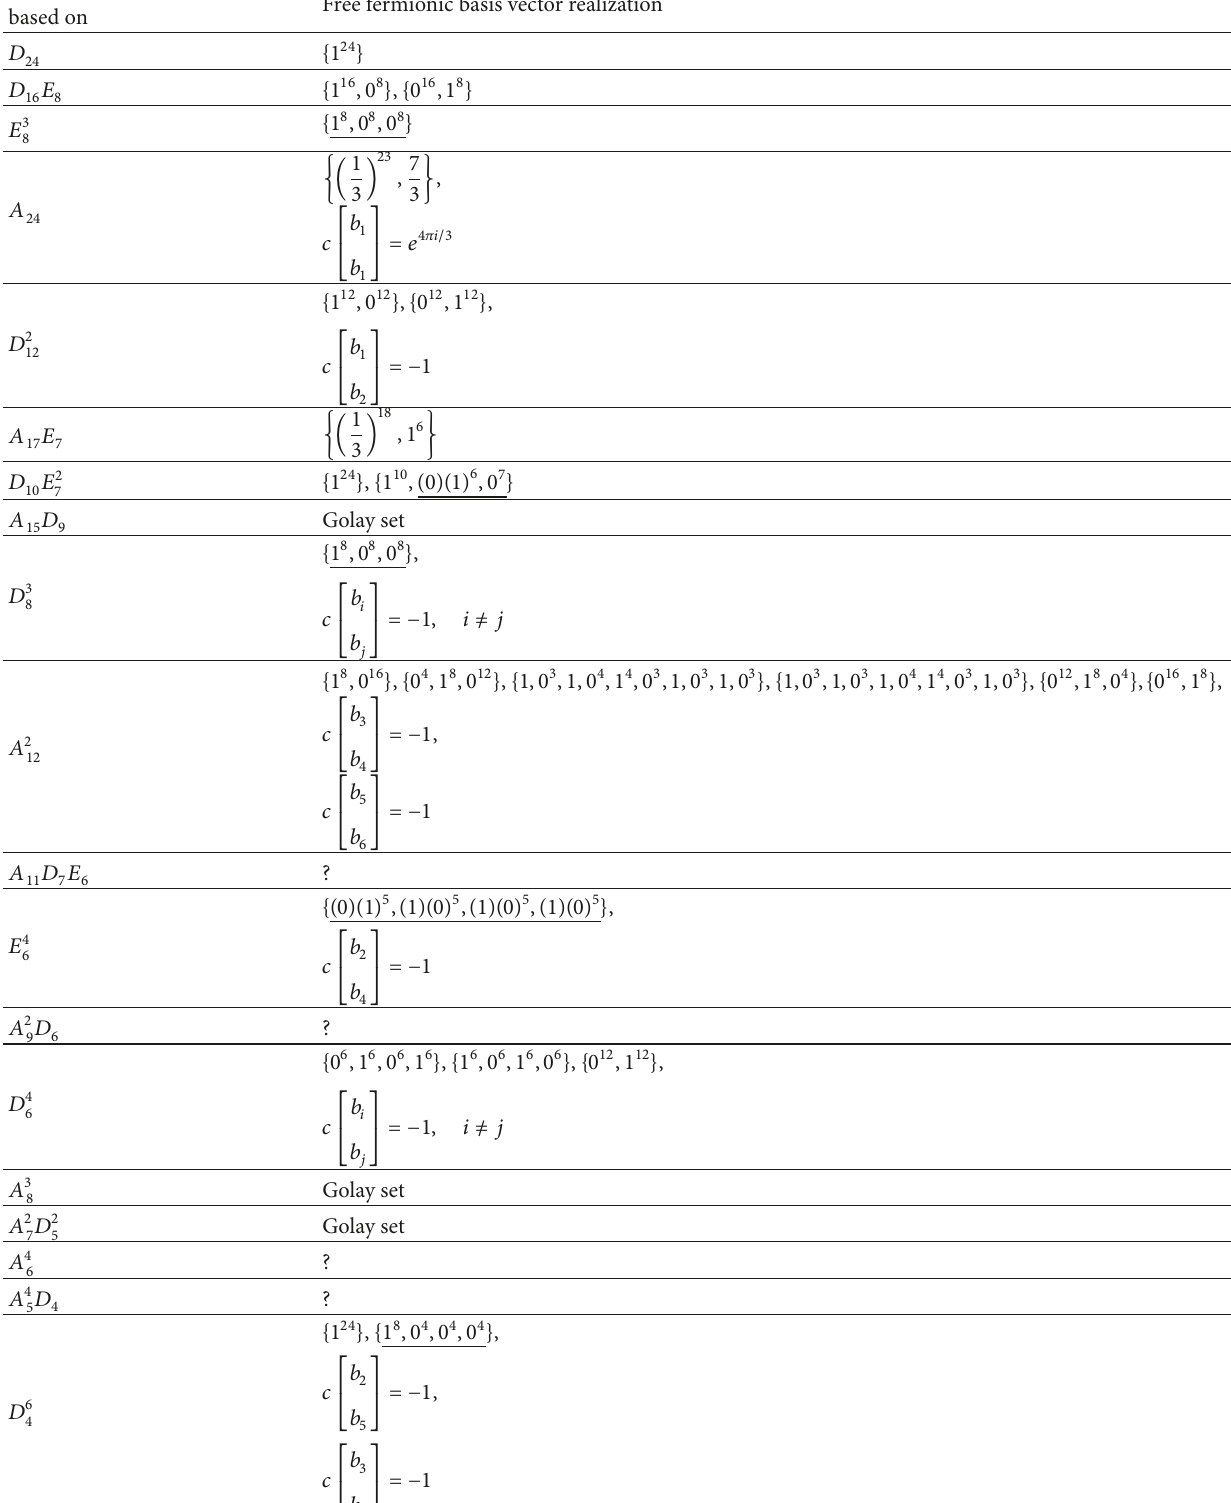
Table 4: Free fermionic realizations of all inequivalent Niemeier lattices. Underline means permutations of all blocks separated by a comma. For example, the three basis vectors needed for 𝐸 3 8 are {1 8 , 0 8 , 0 8 } , {0 8 ,1 8 , 0 8 } , and {0 8 , 0 8 ,1 8 } . Only the 24 right-moving components of the basis vectors appear explicitly; the left-moving ones are understood to be zero. We also state explicitly which generalized phases in the upper triangular part of the phase matrix are not 1 . For a consistent free fermionic model, the vector 𝐻 𝐿 (at least) should also be added to the set to ensure that vector 1 is